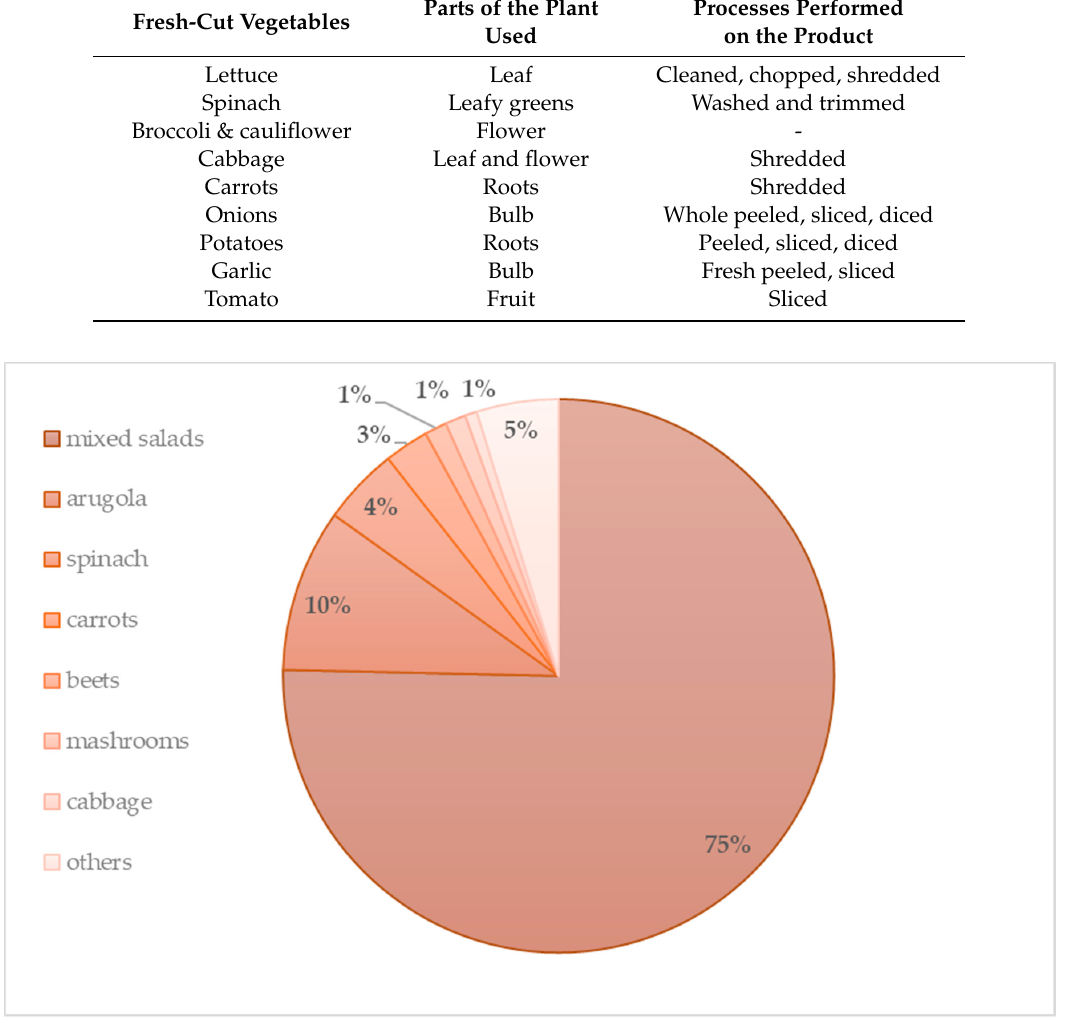
Figure 1. Production of fresh-cut vegetable products in Italy by percentage [19].